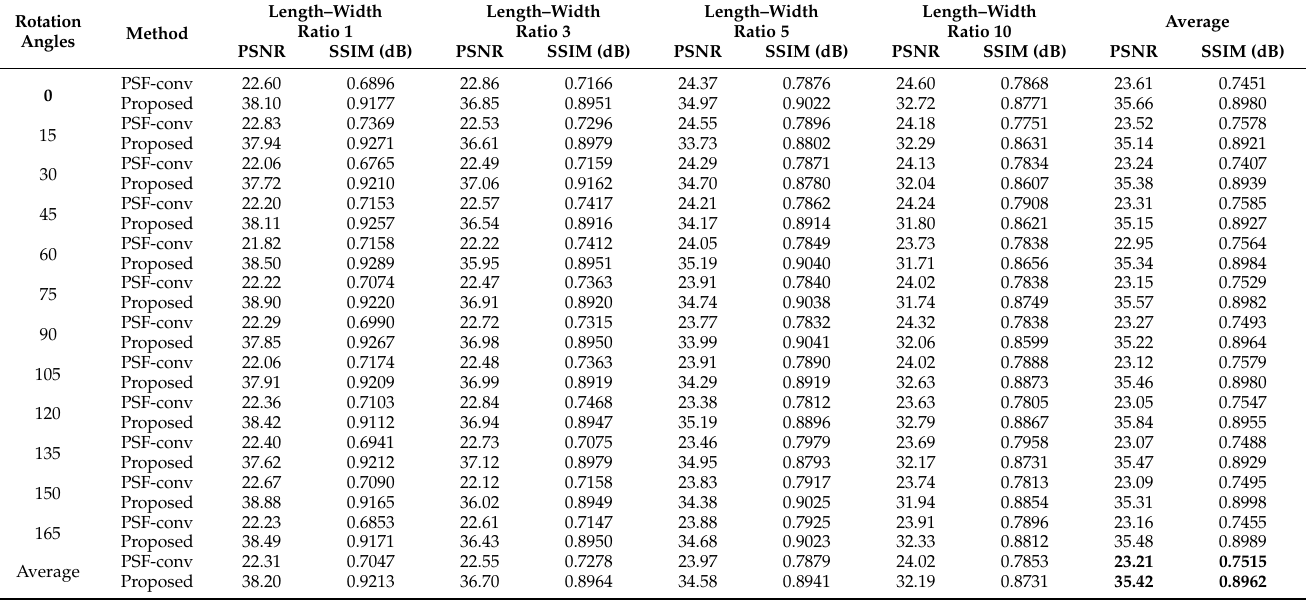
Table 1. Experimental results of 12 rotation angles and 4 length–width ratios. The bold value indicates the average value of all test